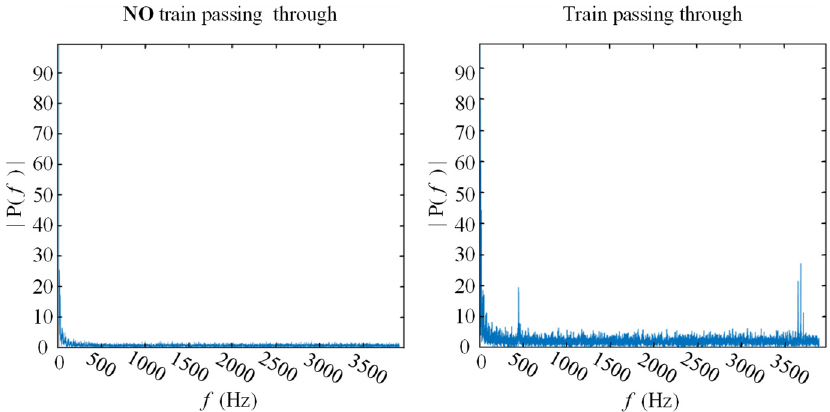
Figure 3. The spectrograms of the measured point with train passing through ( right ) and without train passing through ( left ). Table 1. Event distribution without ‘no-event’. (Position of 0 m: the end near the computer room; Position of 1500 m: the other end).